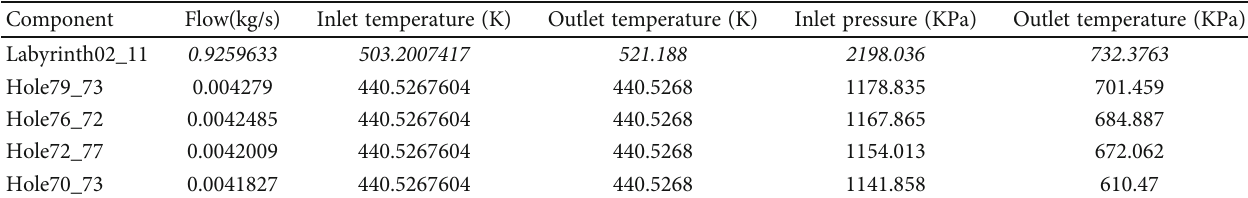
Table 3: Corresponding boundary conditions of the most sensitive fi ve components for system entropy generation.